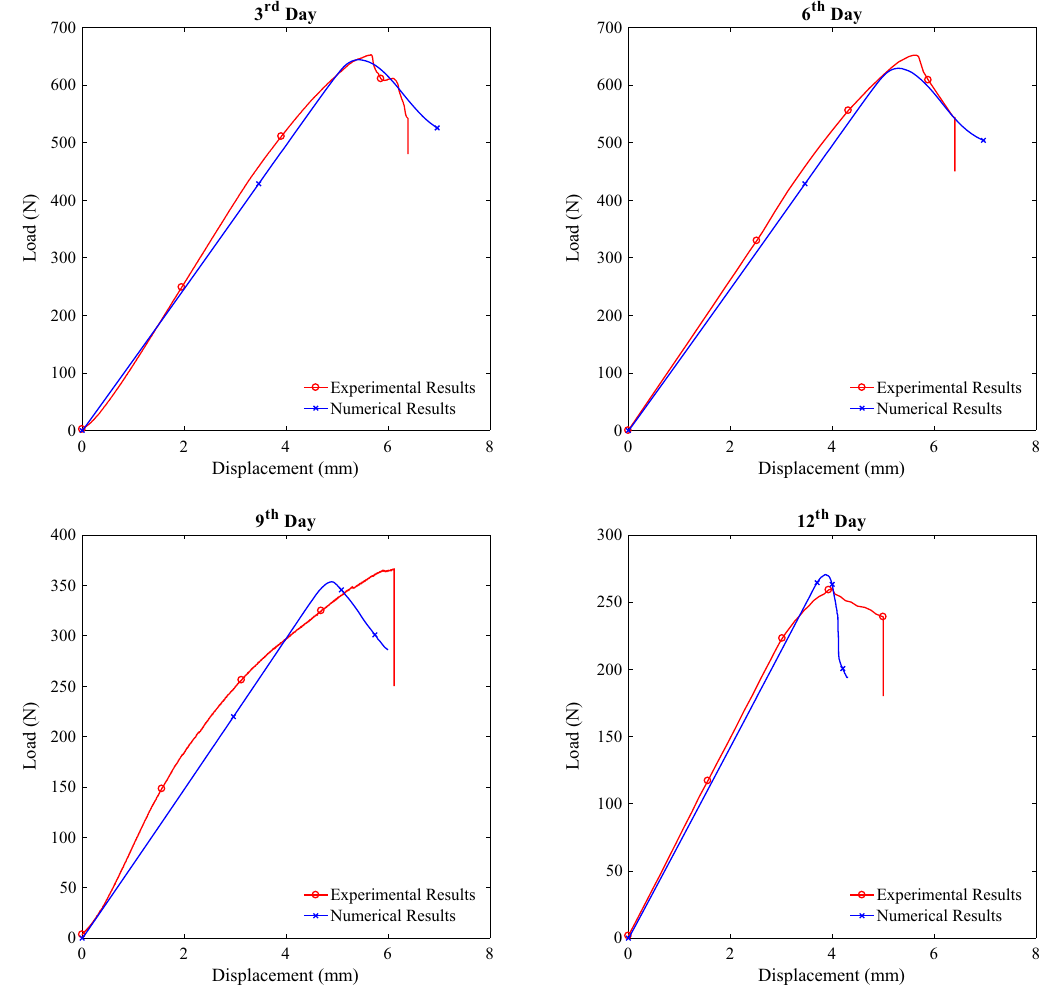
Figure 14: Numerical and experimental load – displacement curves of specimens exposed to an acidic solution at